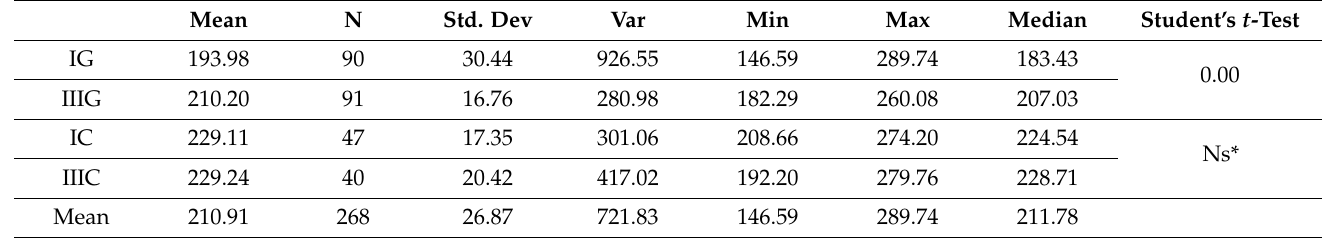
Table 3. Basic statistical parameters for the density [kg/m 3 ] and results of the Student’s t -test for samples collected from the ground section (G) and breast height (C) from both trees.